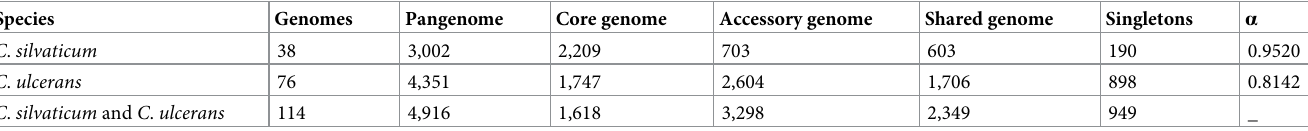
The pangenome is the entire repertoire of orthogroups, the core genome is the subset conserved across all genomes (100%), the accessory genome is the subset not conserved across all genomes, singletons are exclusive from a genome, and the shared genome are orthogroups shared by two or more, but not all